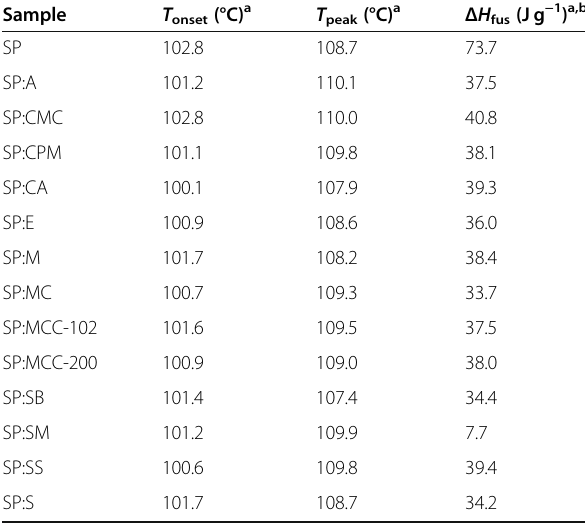
Table 3 DSC thermoanalytical results for SP and binary mixtures with selected excipients